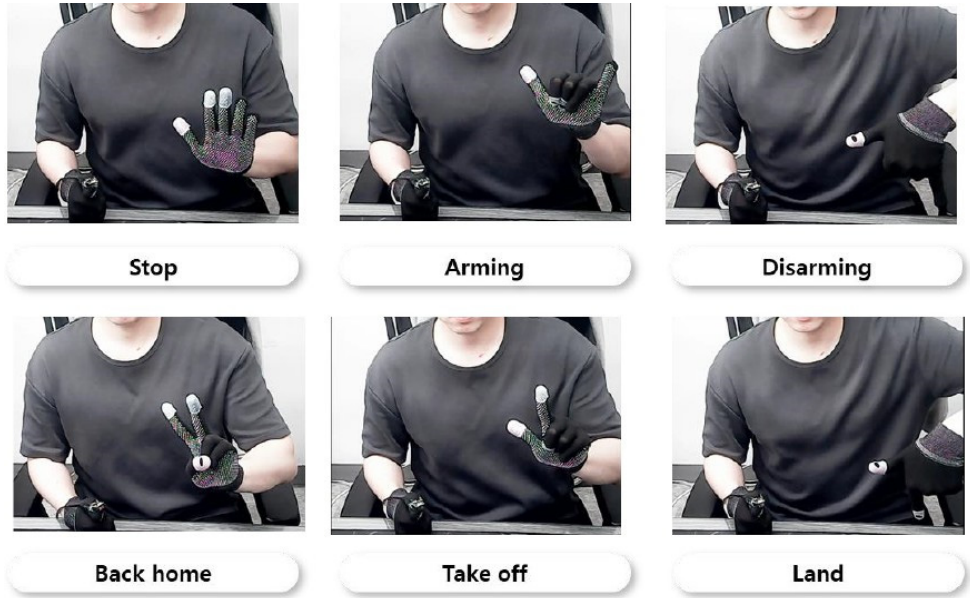
Figure 6. Example of the dataset regarding a gesture definition for each labeled class for vision-based gesture recognition.